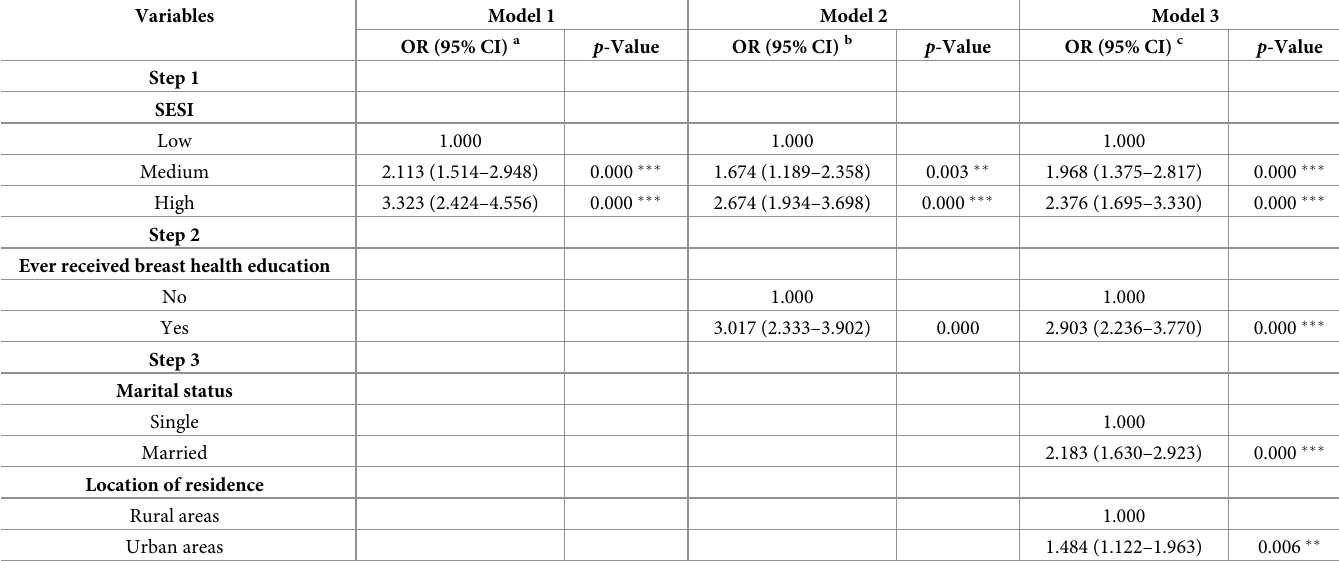
Table 4. Multivariate logistic regressions of BSE practice by SES index (n =